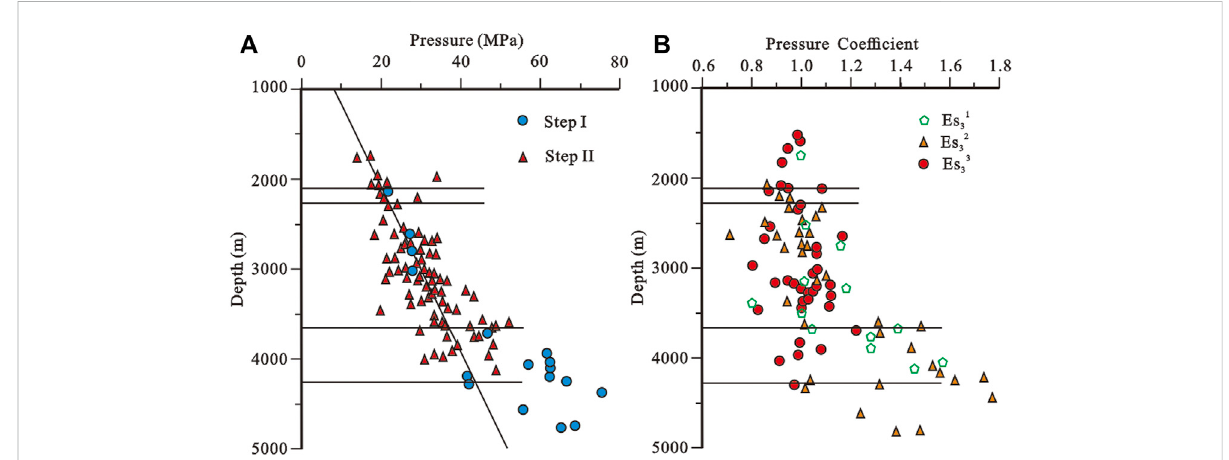
FIGURE 3 (A) Statisticsofmeasuredformation pressure anddepthatdifferentstructuralsteps inthewestern slope beltofDongpuSag. (B) Statisticsofthe